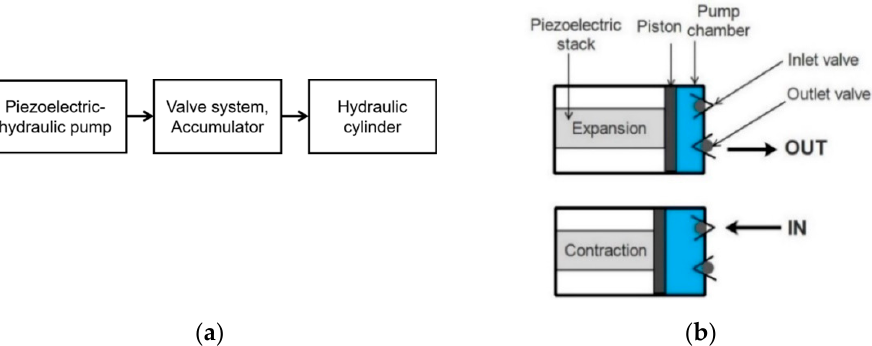
Figure 14. ( a ) Flowchart of the hybrid piezoelectric–hydraulic system. ( b ) Working principle of the piezoelectric-hydraulic pump.